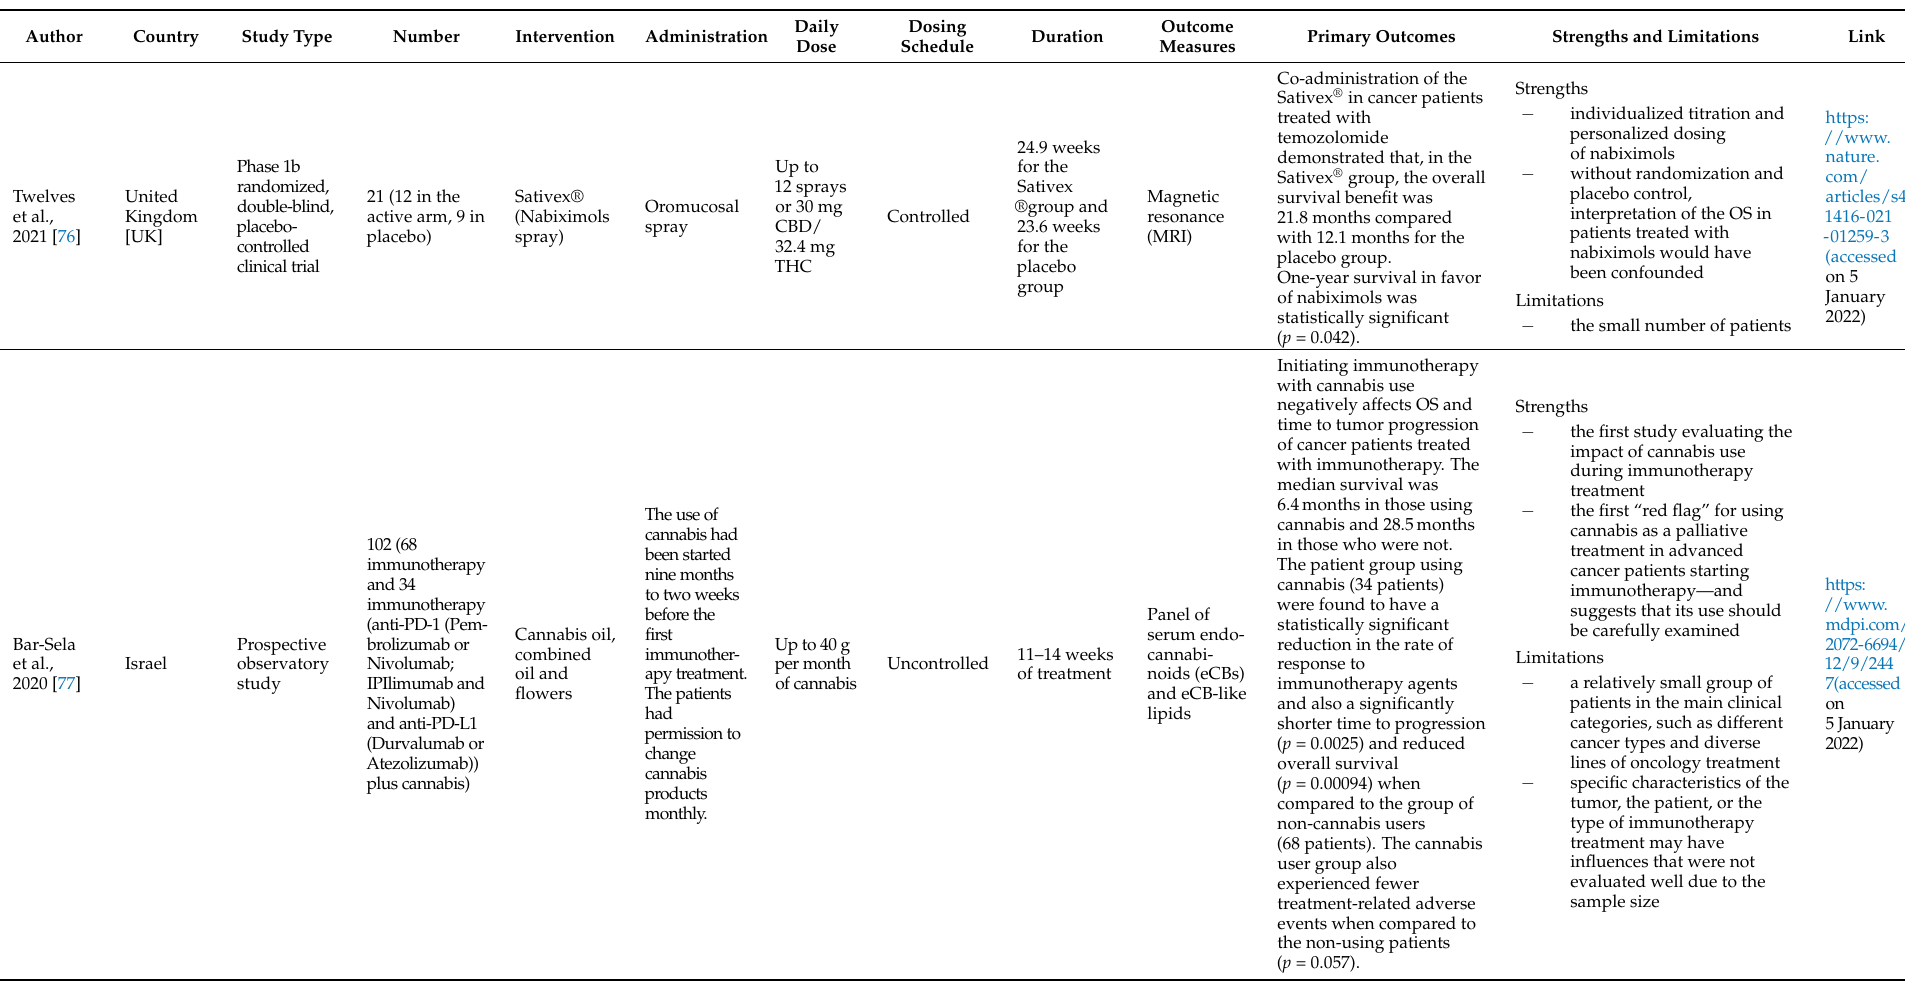
Table 1. Data extraction table in order of medical cannabis intervention type and date, highlighting author, country, study type, number of participants, intervention, administration, daily dose, dosing schedule, duration, outcome measures, primary outcomes, strengths and limitations, and link for articles included in the